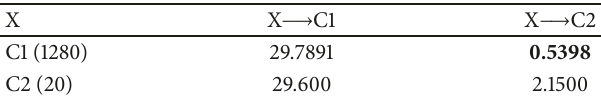
Table 1: The number of nodes in each cluster and the ratio of the numberofedgesbetweenclustersorinsidetheclustertothenumber of nodes in the cluster in Wikipedia who-votes-on-whom network with 2.9% of initial number of nodes in all clusters.